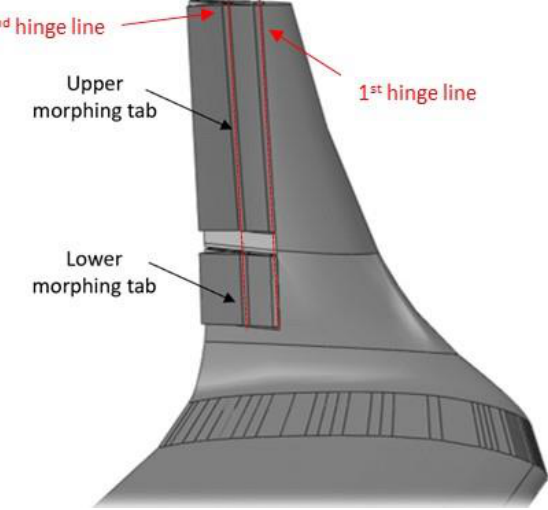
Figure 5. Sketch of the morphing winglet [28] . Figure taken with permission from